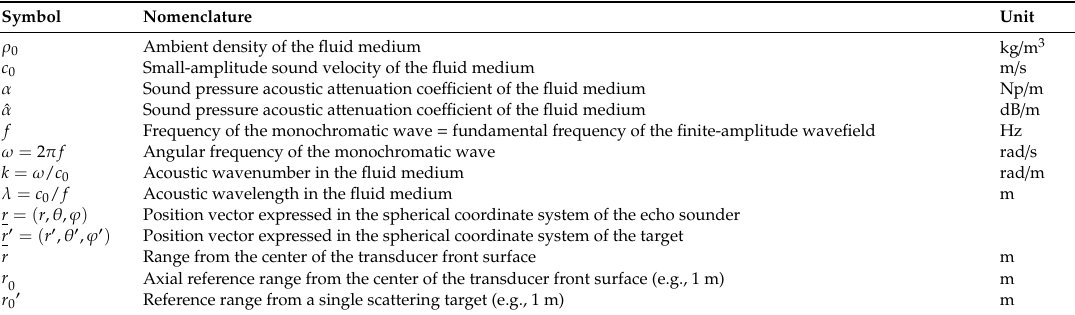
Table A1. List of